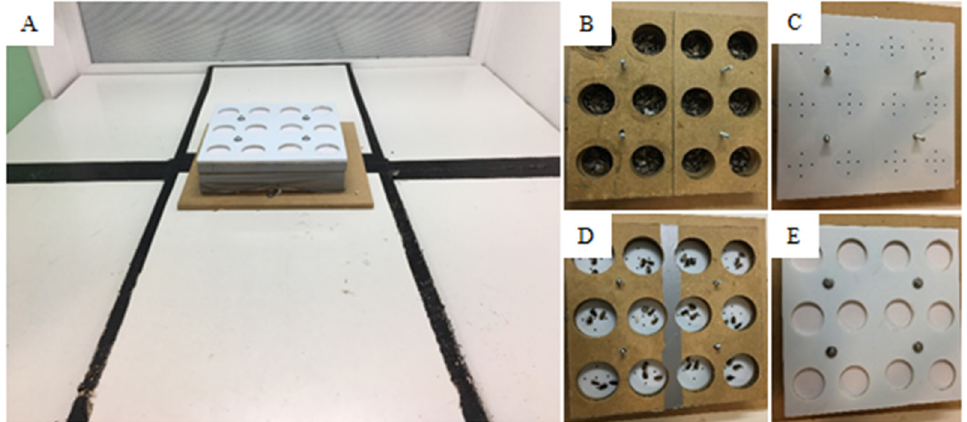
Figure 1. Poke box set up for testing the macaws’ spatial learning performance. ( A ) The set up in the test room; ( B ) base wooden layer with 12 wells filled with inaccessible food (seeds for habituation and nut pieces for training); ( C ) the divider with holes used to separate the top and the bottom layers with holes to release scent; ( D ) the upper wooden layer containing the accessible rewards (seeds or nuts); and ( E ) the top plexiglass layer with paper covering the wells.